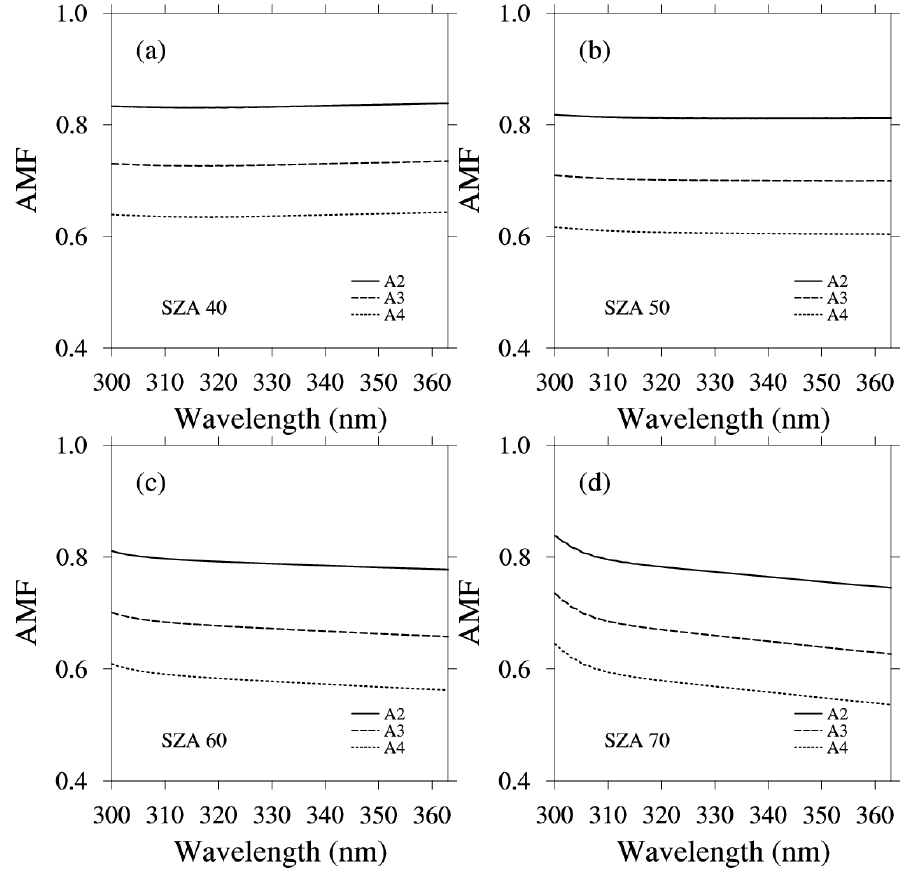
Figure 7. Simulated spectral AMF for A2, A3, and A4 at SZA of: ( a ) 40°; ( b ) 50°; ( c ) 60°; and ( d ) 70°. Table 6. Spectrally averaged theoretical AMF with its standard deviation (Stdev) for all AOD cases in AOD categories, and geometric difference of mean AMF by changing 10° of SZA.